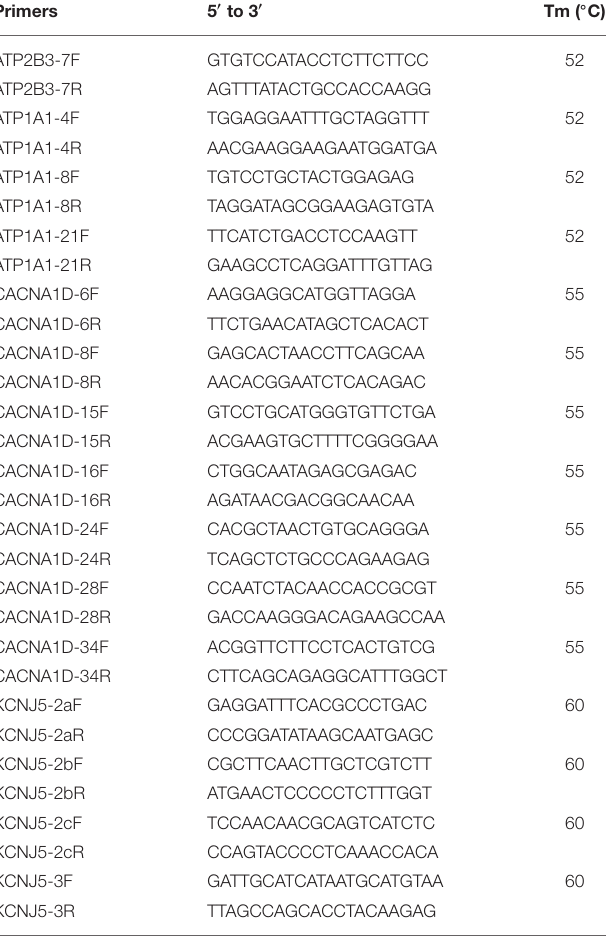
TABLE 2 | The primers of KCNJ5, ATP2B3, ATP1A1, and CACNA1D .